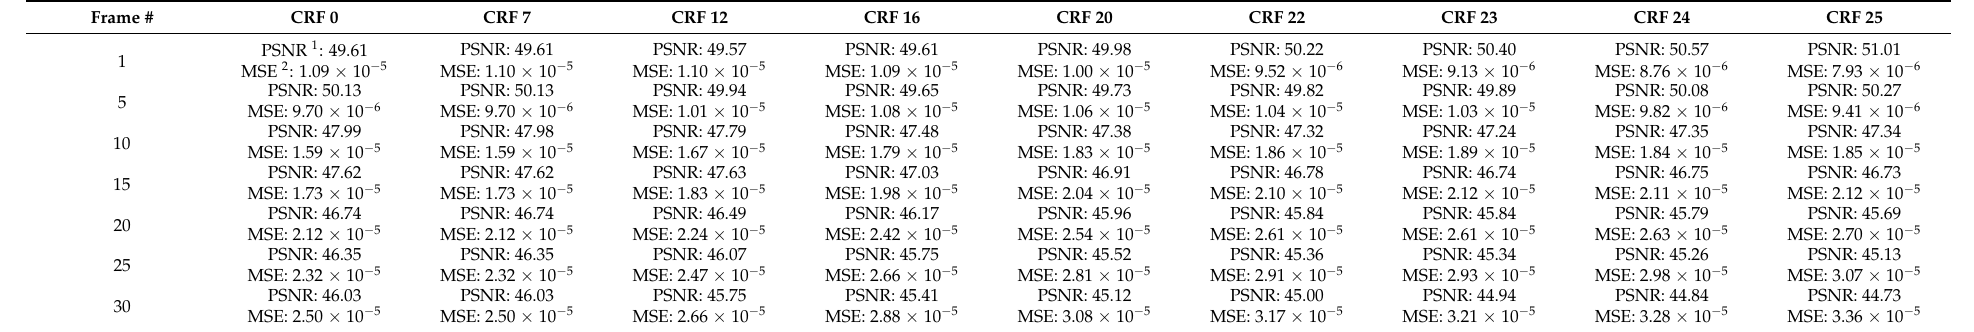
Table 8. Algorithm performance results for a 480 × 640 video fragment encoded with a 128 × 128 encoder trained for CRF = 24 for changes in CRF coefficient compared to a video fragment compressed by HEVC compression in the form of MSE and